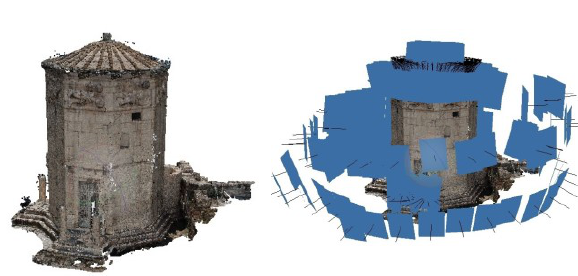
Figure 9: The dense point clouds and the positions of the cameras (blue rectangles) of the exterior of the Tower of the Winds The point cloud for each chunk was created with the highest precision possible, in order to keep all the necessary details of the monument. The point clouds were carefully edited by deleting unnecessary points and unwanted noise and then, the chunks were merged together, resulting in the creation of two integrated parts, which include the exterior (Figure 9) and the interior (Figure 10) of the monument.